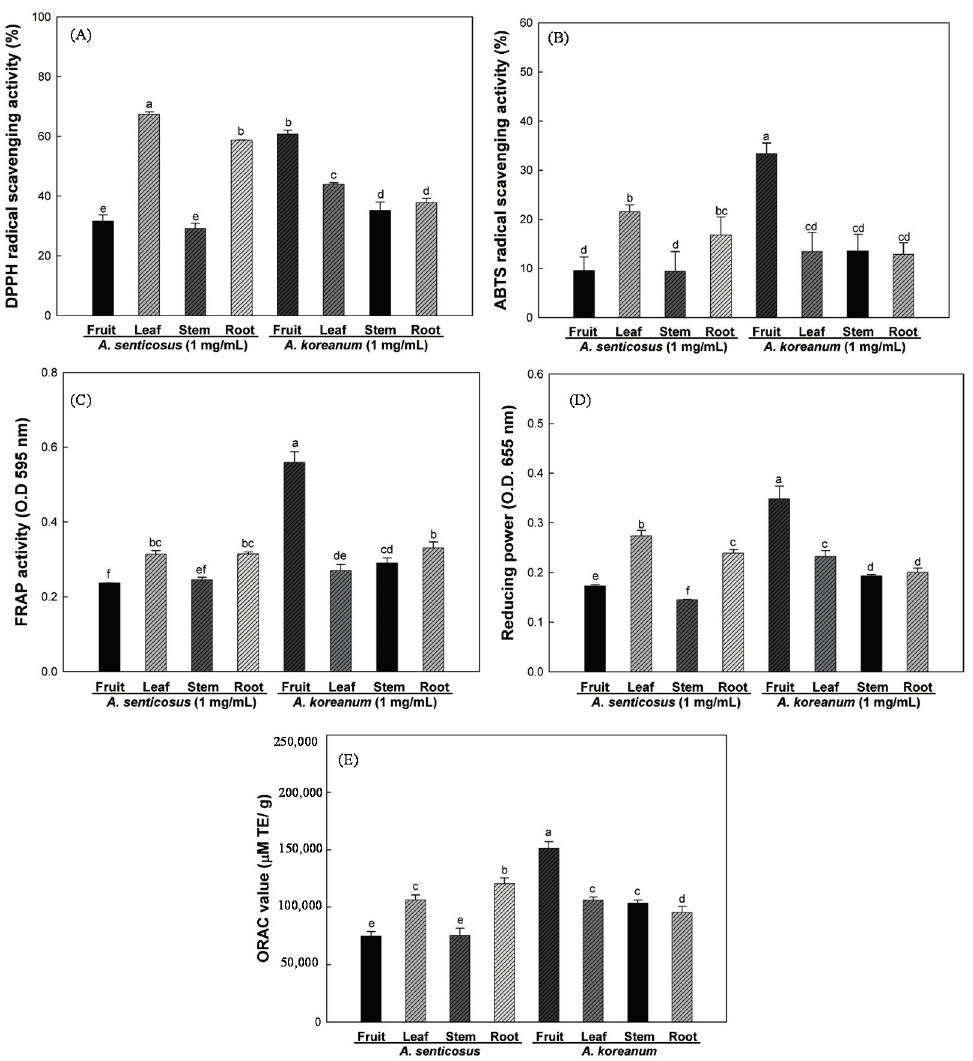
Figure 1. DPPH radical scavenging activity ( A ); ABTS radical scavenging activity ( B ); FRAP activity ( C ); Reducing power ( D ); and ORAC ( E ) in the different parts of A. senticosus and A. koreanum . Each bar represents the mean ± SD of triplicate determinations, n = 3. Statistical analysis was performed using one-way ANOVA ( p <